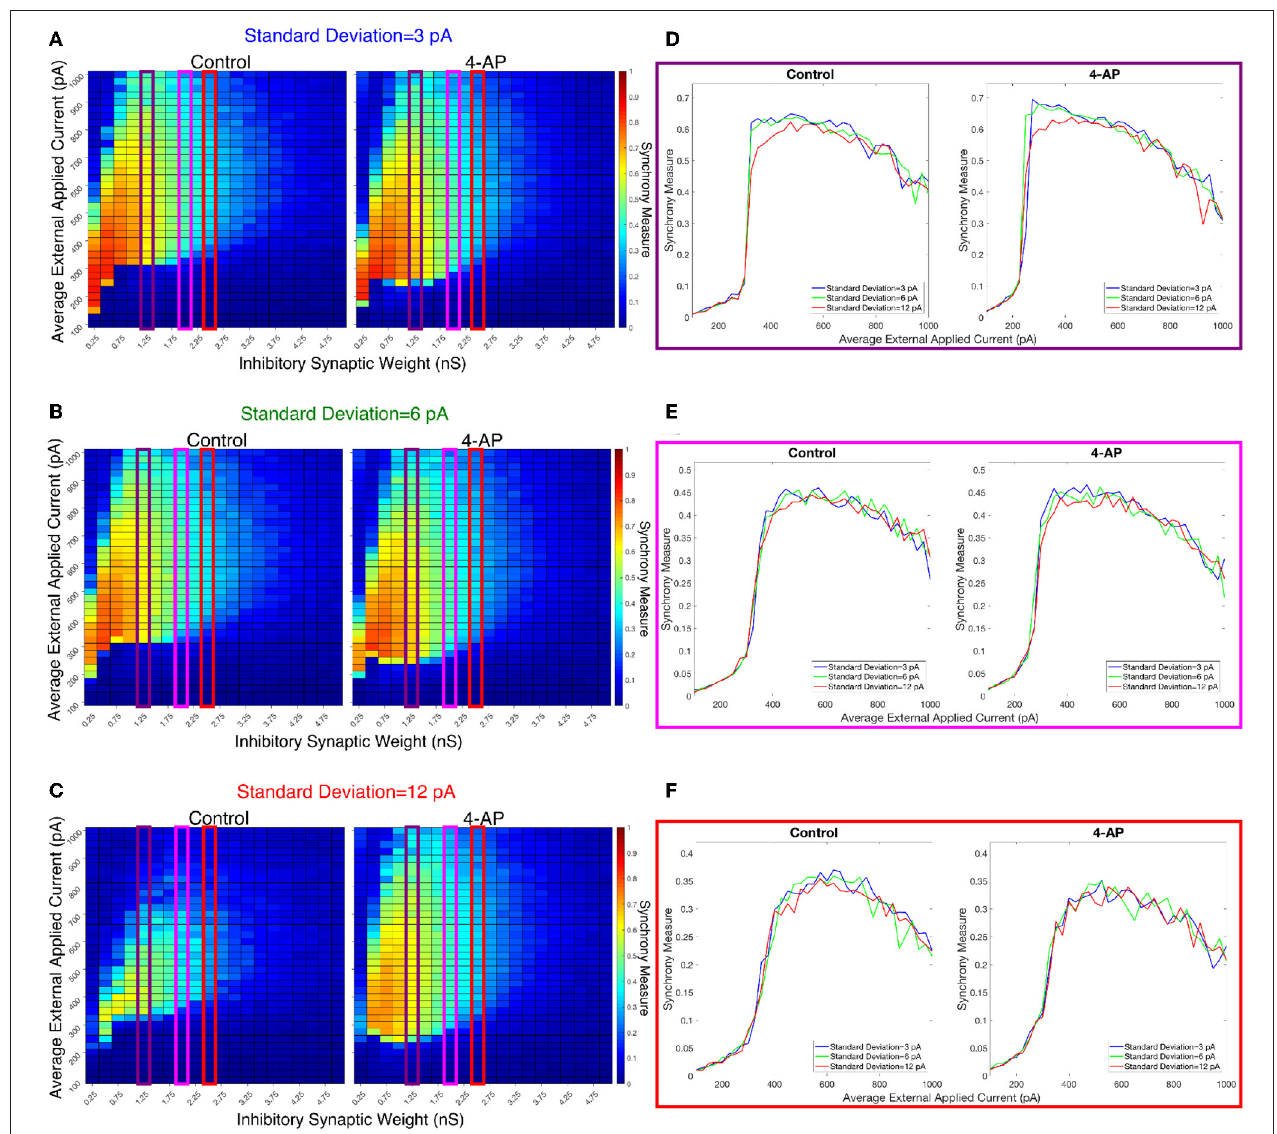
FIGURE 9 | Varying the heterogeneity in external driving current in modeled purely inhibitory networks largely preserves the general dynamical differences and similarities seen between the 4-AP and control cases from randomized initial conditions. (A–C) Heatmaps displaying the Synchrony Measure for control networks (left) and 4-AP networks (right) with a connection probability of 0.12 and varying standard deviations amongst the driving currents. In these heatmaps, the inhibitory synaptic weight is varied along the x-axis and the average external applied current is varied along the y-axis, and the measure is taken from random initial conditions. (D–F) Two dimensional “slices” of the heatmaps in (A–C) taken to better illustrate the sharpness of the transition between asynchronous and synchronous dynamics as well as more easily compare this sharpness both across varying connection probabilities and between control and 4-AP conditions. (D) Shows results for an inhibitory synaptic weight of 1.25 nS, (E) for an inhibitory synaptic weight of 2.0 nS, and (F) for an inhibitory synaptic weight of 2.5 nS. Once again, there is no significant difference in the tendency for 4-AP vs. control networks to exhibit the transition from asynchrony to synchrony, nor any significant differences in the “sharpness” of this